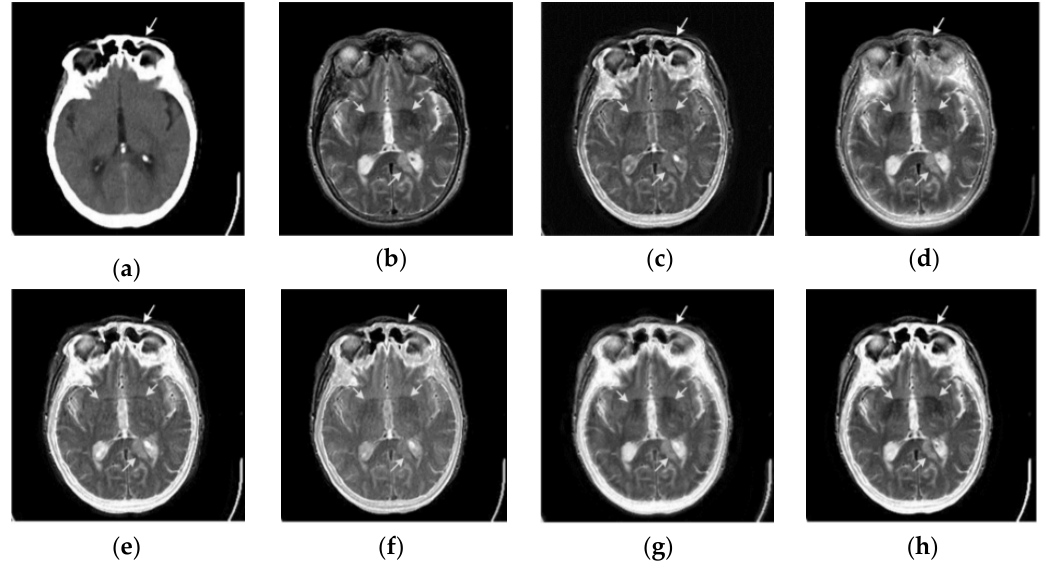
Figure 7. Simulation outcomes of MR-CT image fusion (a) CT input, (b) MR input, (c) MCA-CS [14], (d) LTEM [15], (e) DB-CNN [17],